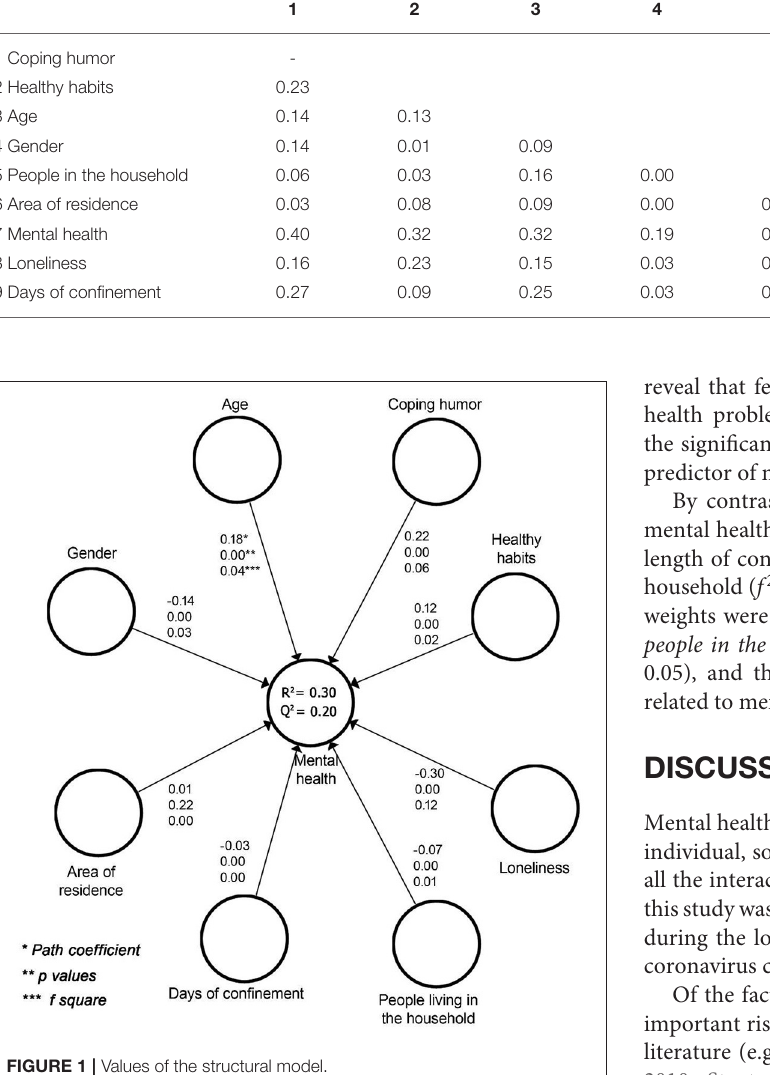
FIGURE 1 | Values of the structural